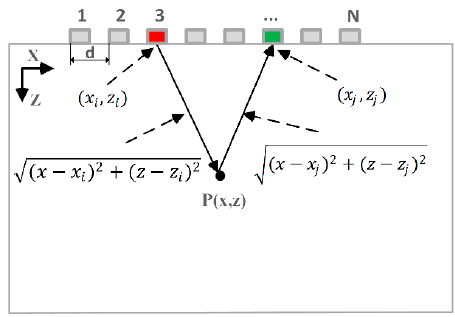
Figure 1. Linear array with N elements, pitch d, and coordinate system.